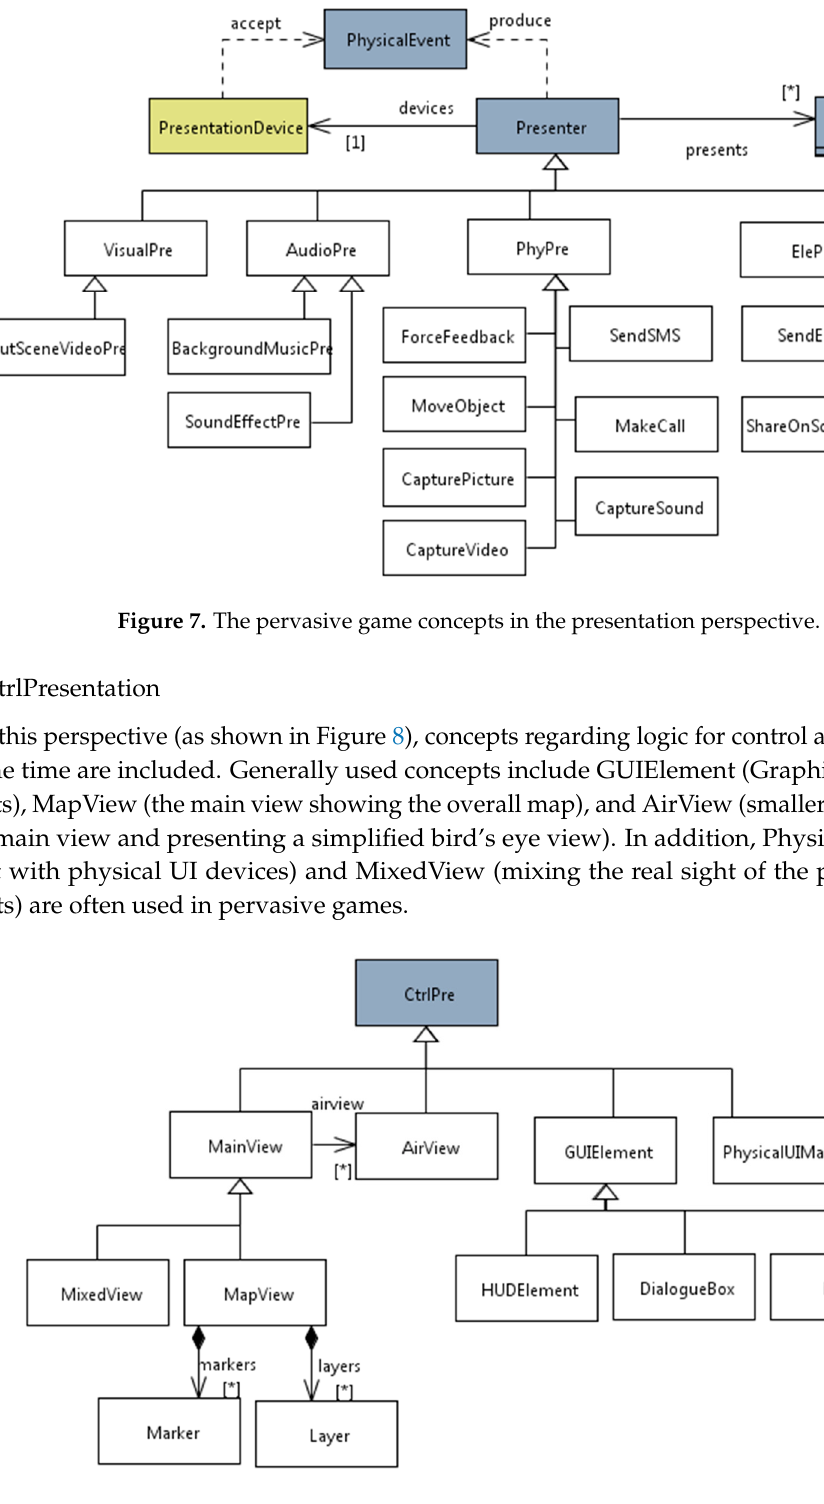
Figure 8. The pervasive game concepts in the CtrlPresentation perspective.